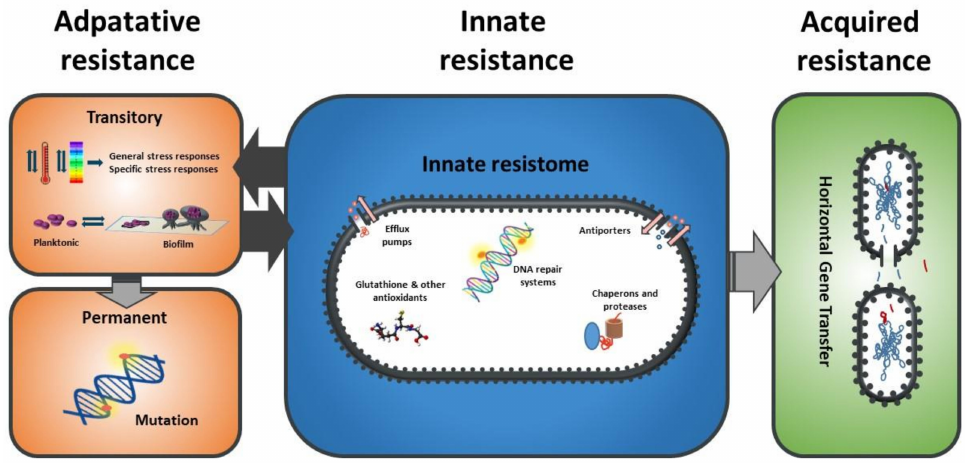
Figure 2. Classification of the mechanisms of stress resistance in bacteria. Bacterial stress resistance mechanisms can also be classified as specific and/or cross- protective, depending on the range of stressing agents to which the structure or molecule provides protection. In the first case, the triggered response only protects against the same agent that induces it. As described below, general stress response is the major representative of the second type of stress resistance